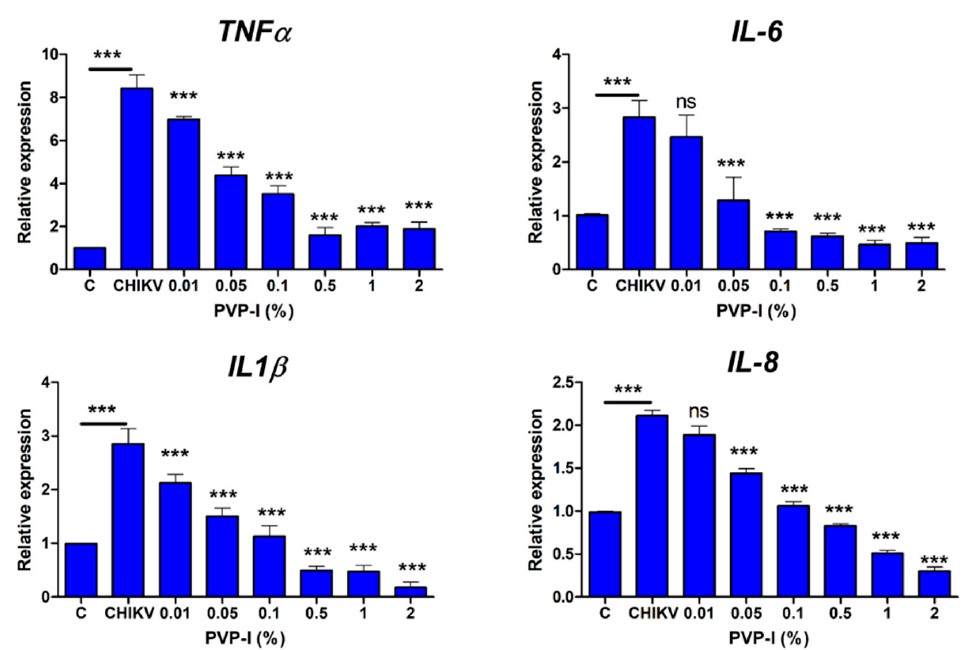
Figure 4. PVP-I treatment reduces CHIKV-induced inflammatory response in corneal epithelial cells. Human corneal epithelial cells (HUCL cell line) were infected at MOI 0.1 for 12 h and exposed to a gradient of PVP-I for one minute. The cells were rinsed and cultured in fresh media for an additional 24 h, followed by isolation of total RNA and cDNA synthesis. The expression of indicated inflammatory genes was assessed by qPCR and the fold change was calculated using the ∆∆ Ct method. The data are presented as relative expressions of genes in CHIKV-infected and PVP-I-untreated versus PVP-I-treated cells using GAPDH as the housekeeping gene. One-way ANOVA Bonferroni test was used for the statistical analysis wherein, *** p < 0.001; ns, not significant. Our data showed a significant reduction in the expression of TNF α and IL1 β at ≥ 0.01% PVP-I and at ≥ 0.05% PVP-I for IL-6 and IL-8